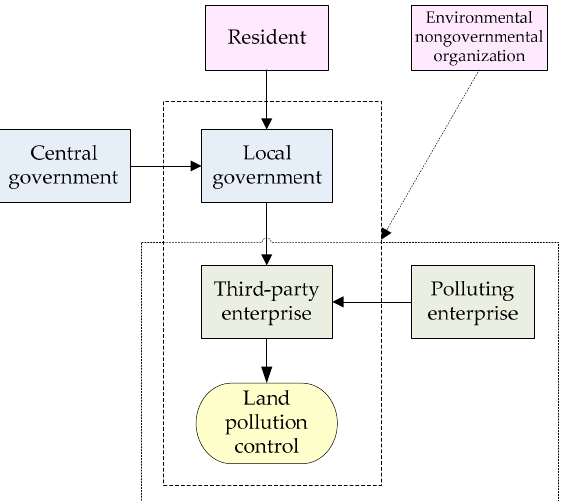
Figure 2. Participants’ relationships of the third-party soil pollution control in China.